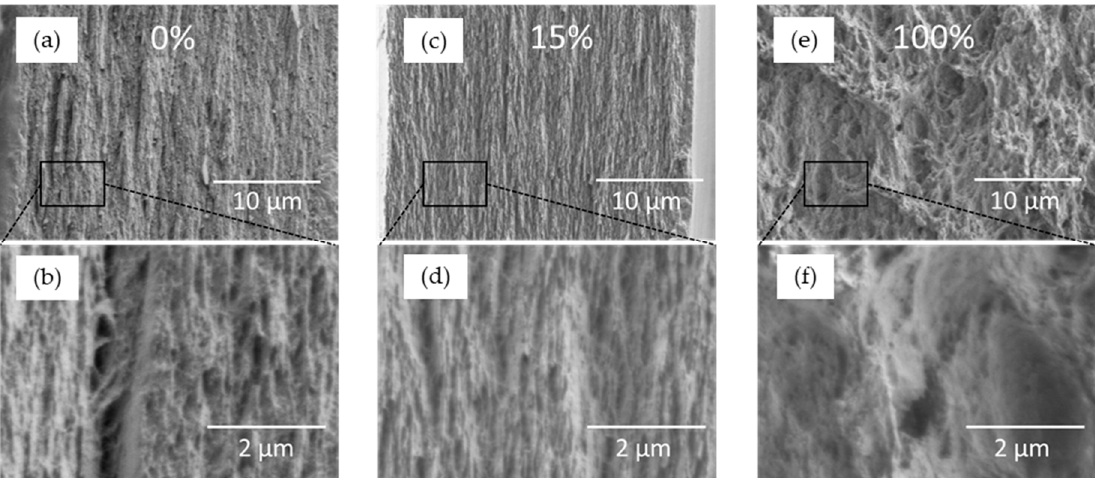
Figure 5. SEM micrographs of the neat CNF ( a , b ), the 15% AC composite ( c , d ), and the neat amorphous ( e , f ) films at two magnifications, in which the horizontal is normal to the film and in a vertical direction along the film plane. Both CNF and the 15% AC show structures aligned parallel to the film plane, and neat amorphous cellulose film appears isotropic.